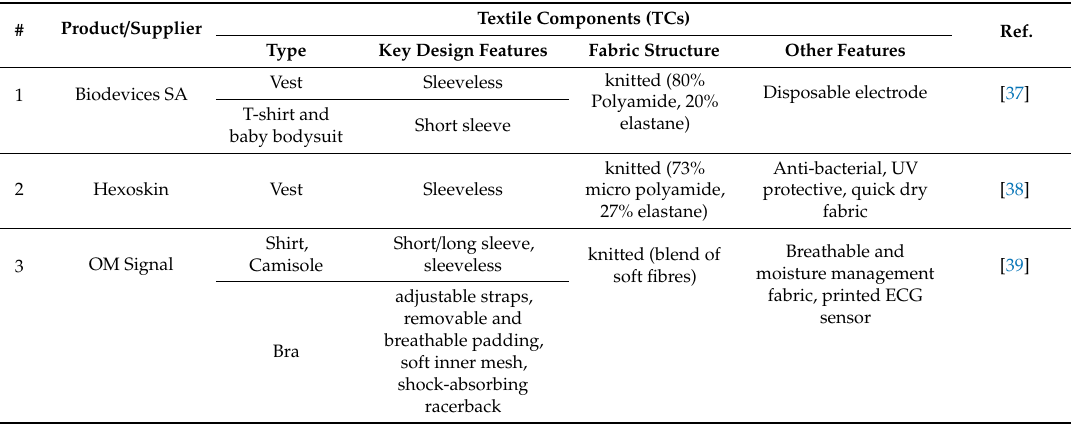
Table 2. Features of the textile components (TCs) of available SeCSs for health monitoring. ECG, electrocardiogram.